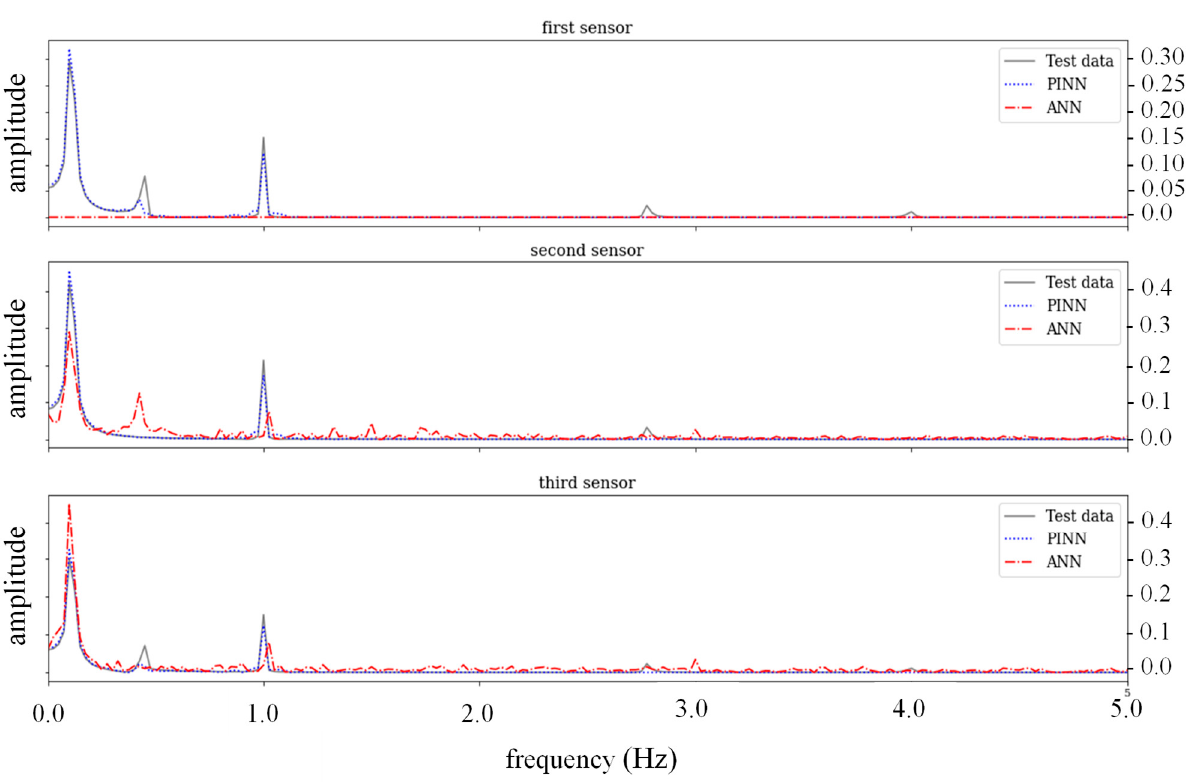
Figure 25. FFT analysis on the PINN and ANN state estimations with modified hidden layers for the test period.